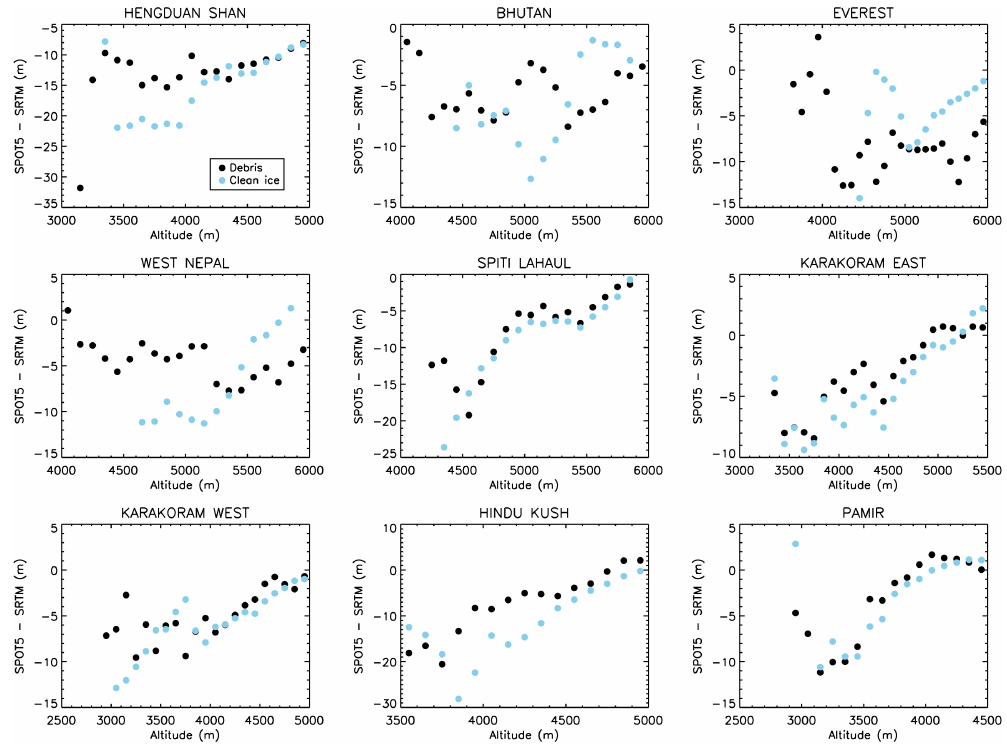
Fig. 11. Elevation changes (SPOT5-SRTM) in the ablation area for clean ice (blue circles) and debris-covered ice (black circles) for each study site. For the Karakoram (east and west) and the Pamir study sites, only non-surge-type glaciers are considered. Standard error of the elevation differences are typically less than ± 2m with each 100m elevation band (not shown for the sake of clarity). Note, elevation changes over separate sections of a glacier cannot be treated as mass changes due to the disregard of glacier